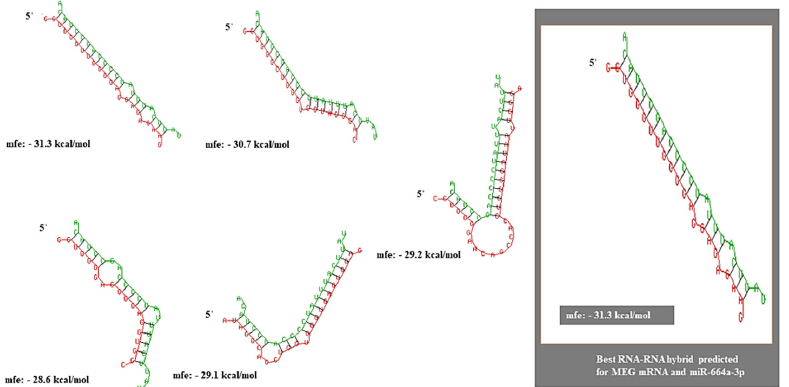
Figure 4. RNA heteroduplexes constructed for lncRNA-MEG3 and miR-664a-3p with the top five predicted lncRNA–miRNA interactions. The best possible model with an MFE of − 31.3 kcal/mol is highlighted.